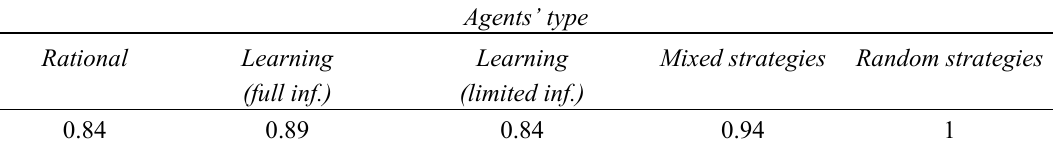
Table 3. VAR-based forecasts’ RMSEs (as ratio to the AR-based forecasts’